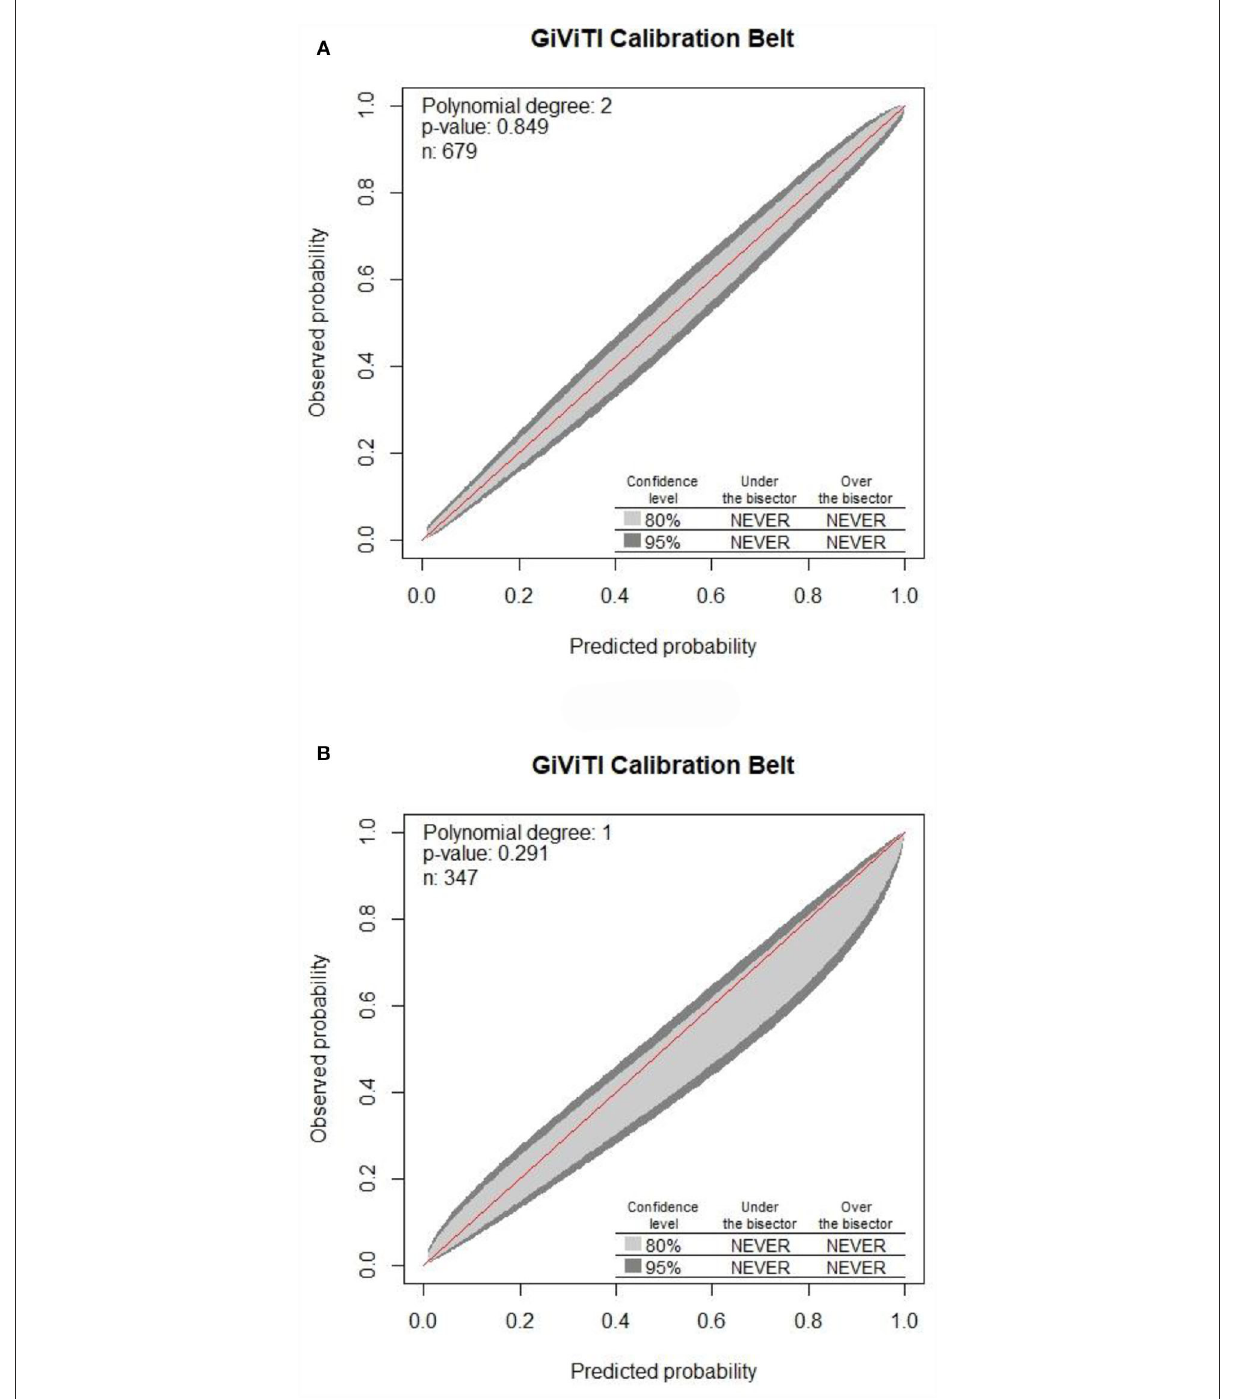
FIGURE6 Calibration of the nomogram for DRE prediction in the training set along with the validation set. The 80% CI and 95% CI of the GiViTI calibration belt for either the training set (A) or validation set (B) did not surpass the diagonal line, with P -values of 0.849 for the training set compared to that of 0.291 for the validation set in the GiViTI calibration belt ( P > 0.05).